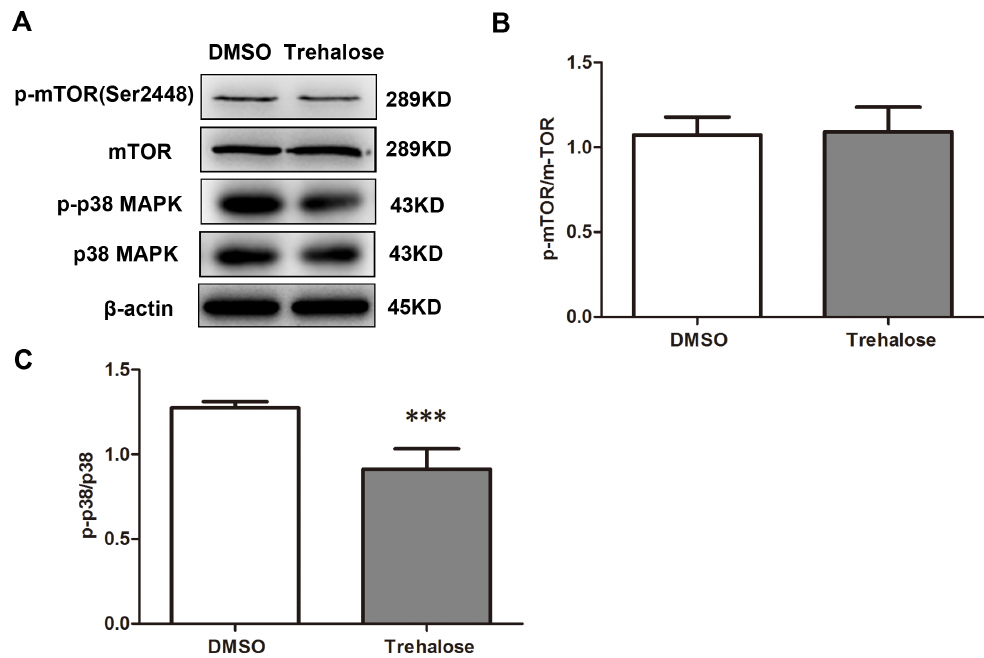
Fig 4. Trehalose activated the p38 MAPK signaling pathway in cryopreserved valve cells. (A, B and C) Western blotting using p-mTOR (Ser2448), mTOR, p38 MAPK and p-p38 MAPK antibodies on cryopreserved valve cells treated with trehalose (0.1 mol/L) or DMSO for 16 weeks. Data are expressed as the mean ± SD ( n = 20 per group). (cid:3)(cid:3)(cid:3) P < 0.001 versus the DMSO group.